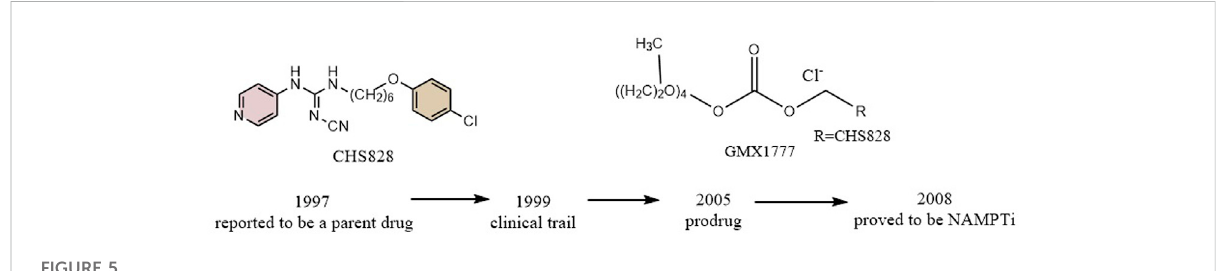
FIGURE 5 Discovery and research history of the NAMPT inhibitor